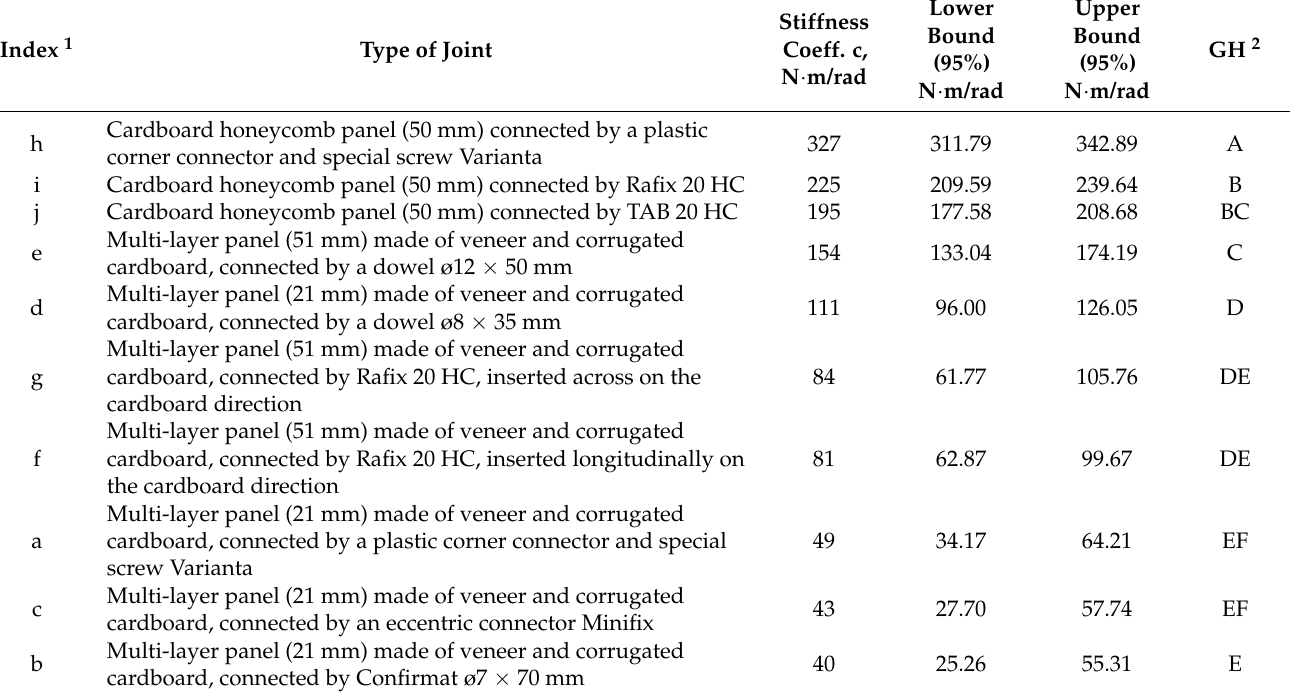
Table 5. Tukey HSD analysis of the differences between the groups with a confidence interval of 95% of stiffness coefficients of joints of two materials of all pairwise comparisons.